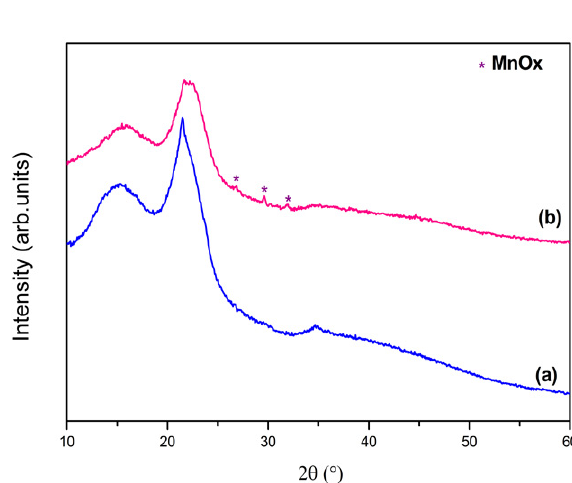
Fig. 12. Comparison in XRD patterns of Ac-OFIP (a) and Mn-Ac- OFIP